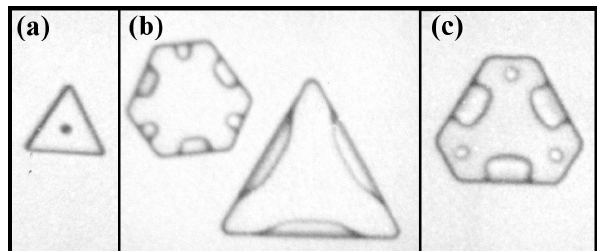
Figure B15. Trigonal and scalene hexagonal. (a) Trigonal. (b) Both types. (c) Scalene hexagonal. All crystals grown for about 310s at − 10 . 2 ◦ C in the cloud chamber (courtesy of Akira Yamashita). Di- ameters are about